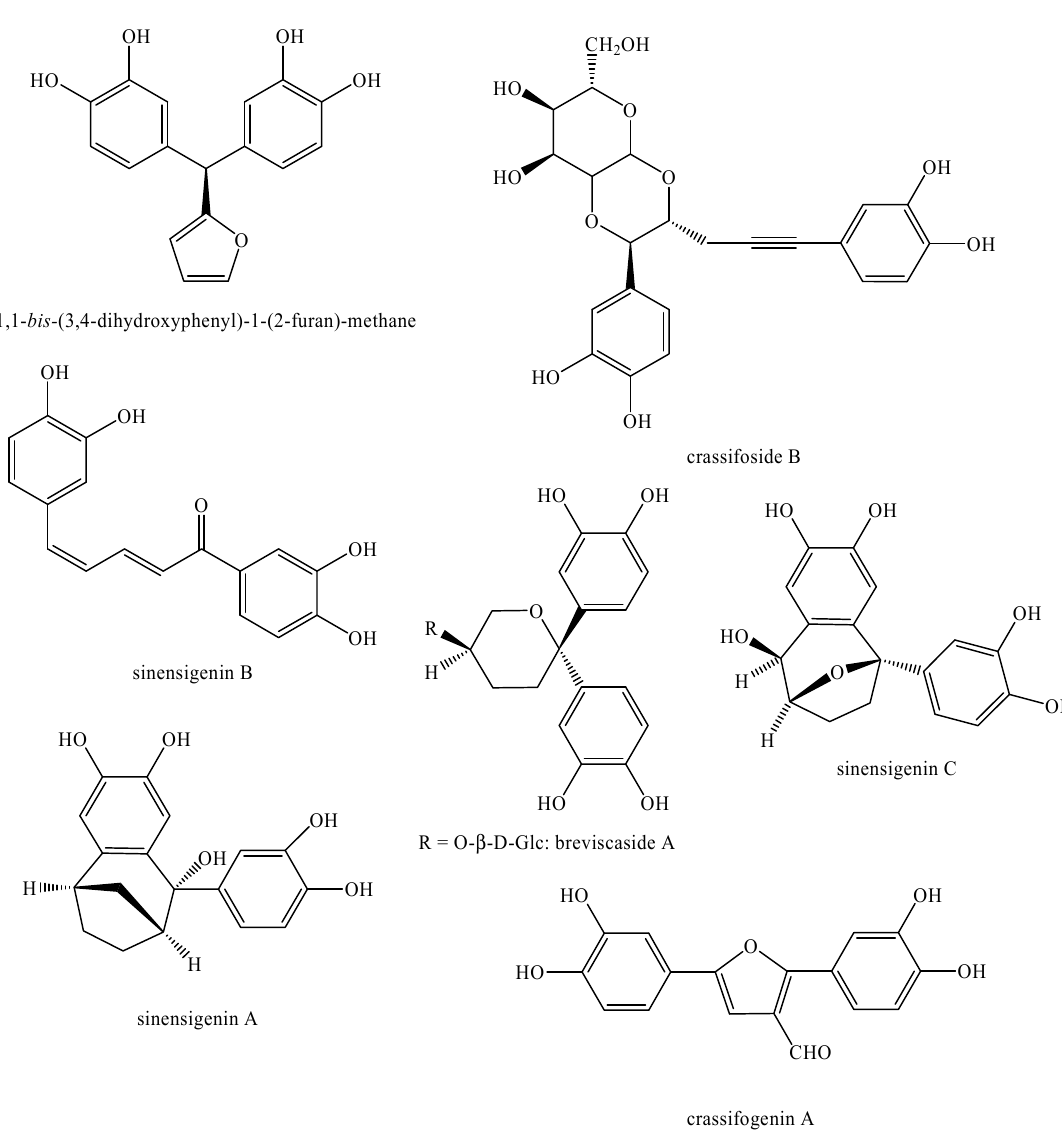
Figure 11. Isolated nor -lignans in the plant kingdom—part 10.